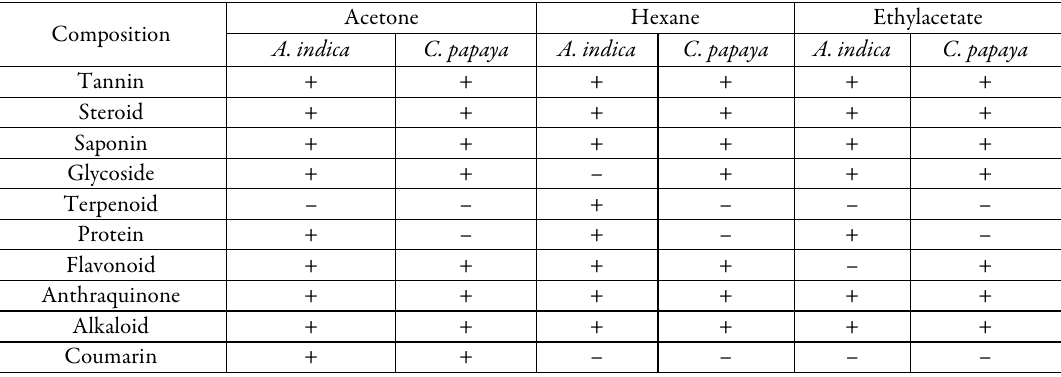
Table 1. Preliminary phytochemical constituents of acetone, hexane and ethylacetate extracts of Carica papaya and Azadirachta indica leaves Composition